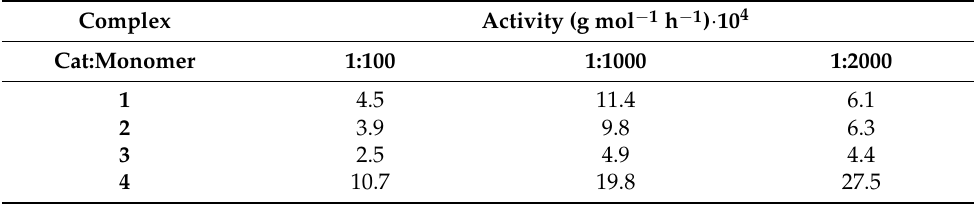
Table 2. Polymerization results for the ROP of ε -caprolactone mediated by complexes 1 – 4 . Complex